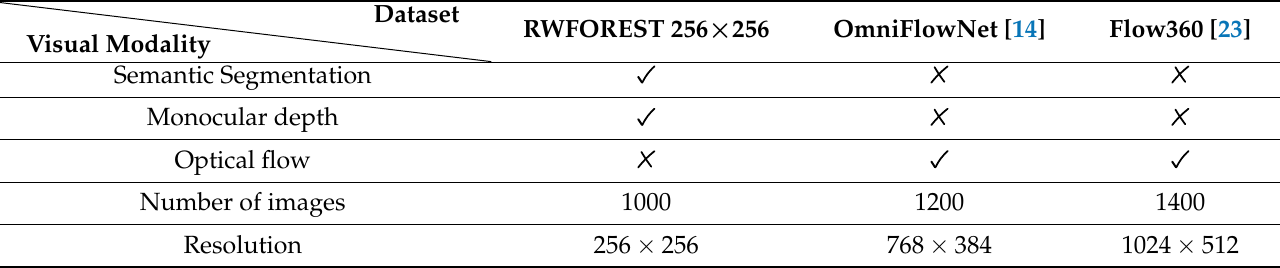
Table 1. Equirectangular datasets used to test the different adapted networks. The visual ground-truth modalities present in the dataset are pinpointed, always associated with equirectangular RGB images.